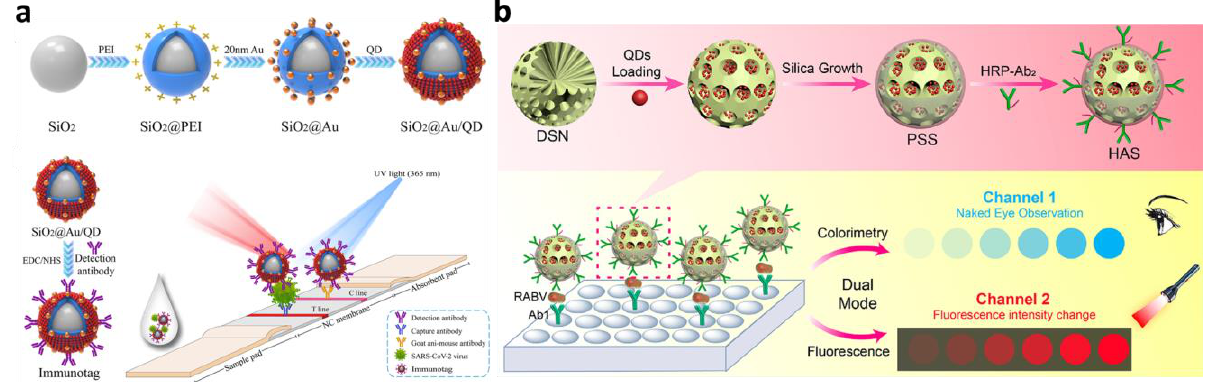
Figure 8. Schemes follow the same formatting. Schematic diagram of functionalized silica nano- sphere for signal amplification. ( a ) Fabrication of silica nanosphere encapsulating Au/QDs for dual- functional SARS-CoV-2 LFA biosensor. Adapted with permission from [68] . Copyright 2022, Elsevier. ( b ) Illustration of silica nanosphere functionalized with QDs and horseradish peroxidase (HRP) − labeled antibody for dual-modal rabies virus immunoassay biosensor. Adapted with permission from [72] . Copyright 2020, American Chemical Society.